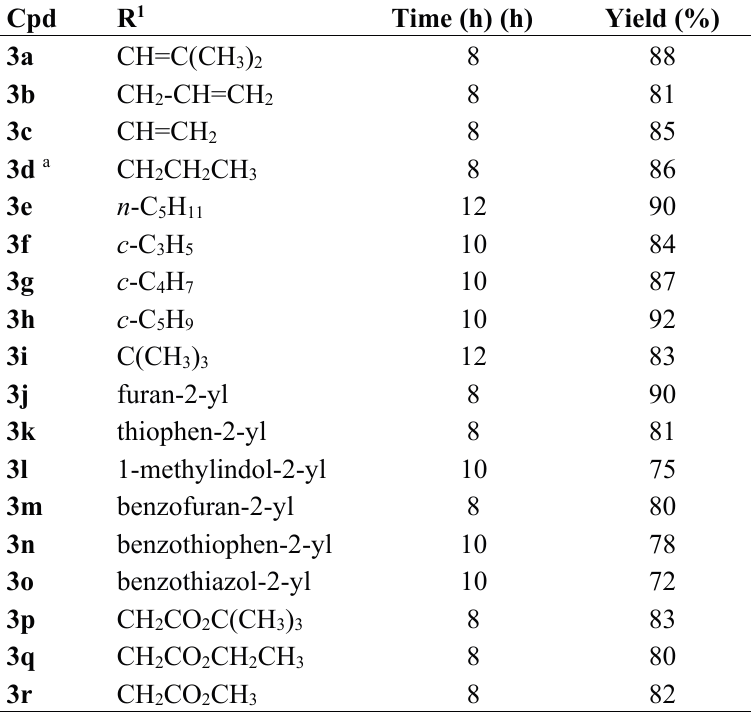
Table 2. Product